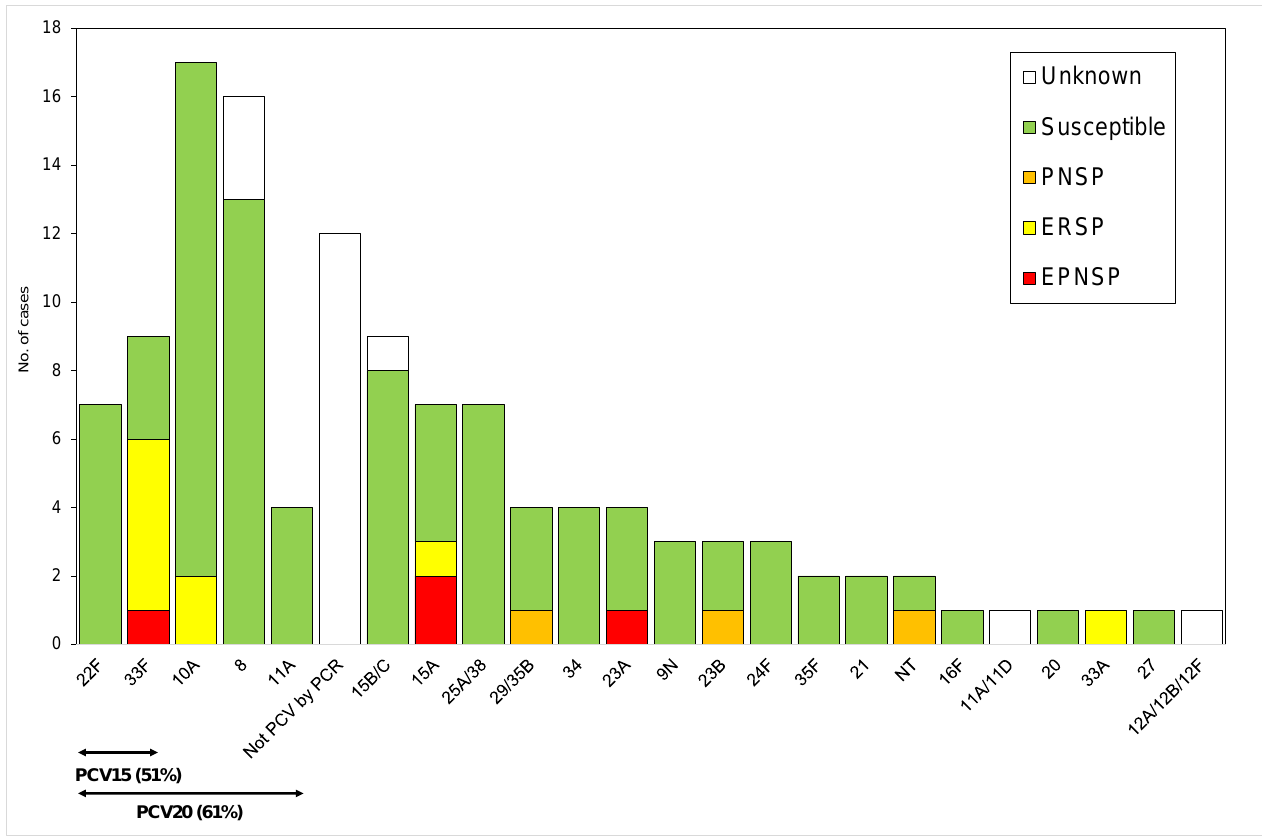
Figure 2. Number of samples representing serotypes not present in previously and currently available conjugate vaccines causing invasive infections in Portugal (2015–2016 to 2017–2018). See the legend of Figure 1. NT—Non-typeable. Some serotypes could not be unambiguously determined and are indicated as such (see text). Among the 15B/C IPD cases are eight in which isolates could be recovered—15B ( n = 7) and 15C ( n = 1)—and one detected by PCR. The proportion of isolates expressing serotypes represented in PCV15 and PCV20 is 51% and 61%, respectively. The potential coverage of PCV20 was calculated excluding the three samples in which the serotypes could not be unambiguously identified and that included PCV20 serotypes: 15B/C, 11A/D and 12A/B/F. Since our PCR serotyping schema does not detect serotype 10A it is possible that some of the samples for which a serotype could not be identified (“Not PCV by PCR”) represent this serotype which could further increase the potential coverage of PCV20.